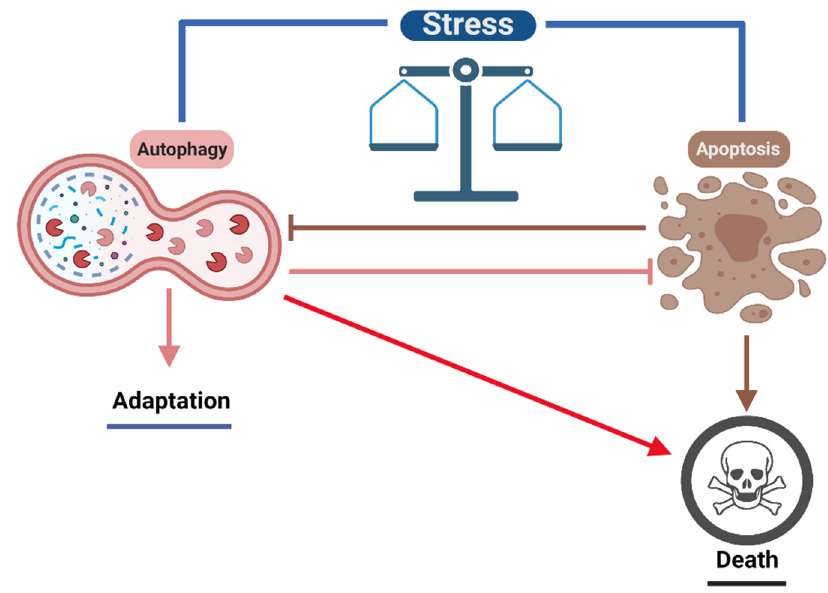
Figure 3. The balance between autophagy and apoptosis in stress conditions. According to stress stimuli, the cell has an adaption process associated with autophagy or decides to die in an apoptosis process. The choice depends on the microinvironmetal: nutrient availability, and prolonged time in stress conditions, among others. “Created with BioRender.com (accessed on 1 May 2022).”